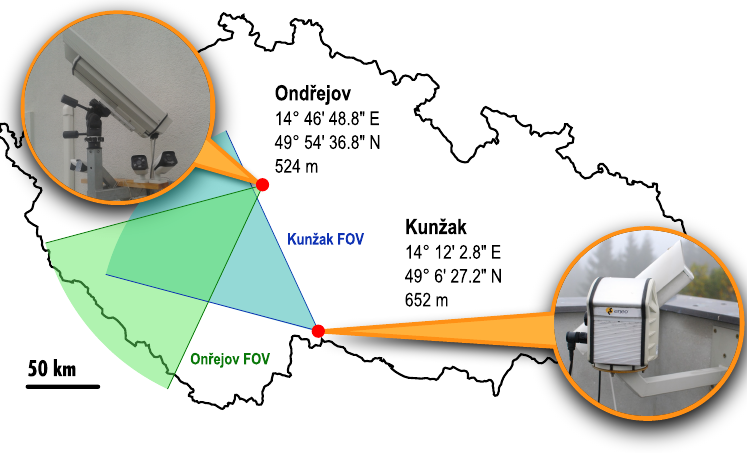
Figure 1. Location of the Meteor Automatic Imager and Analyzer (MAIA) stations. FOV: field of